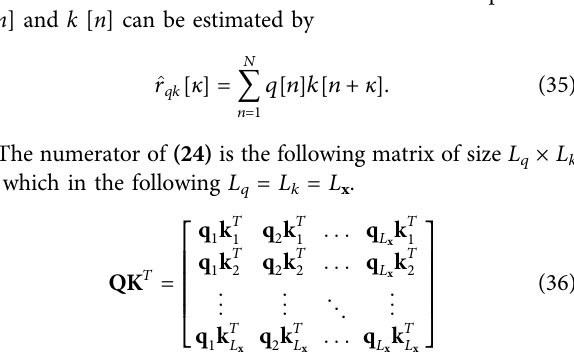
Frontiers in Signal Processing |